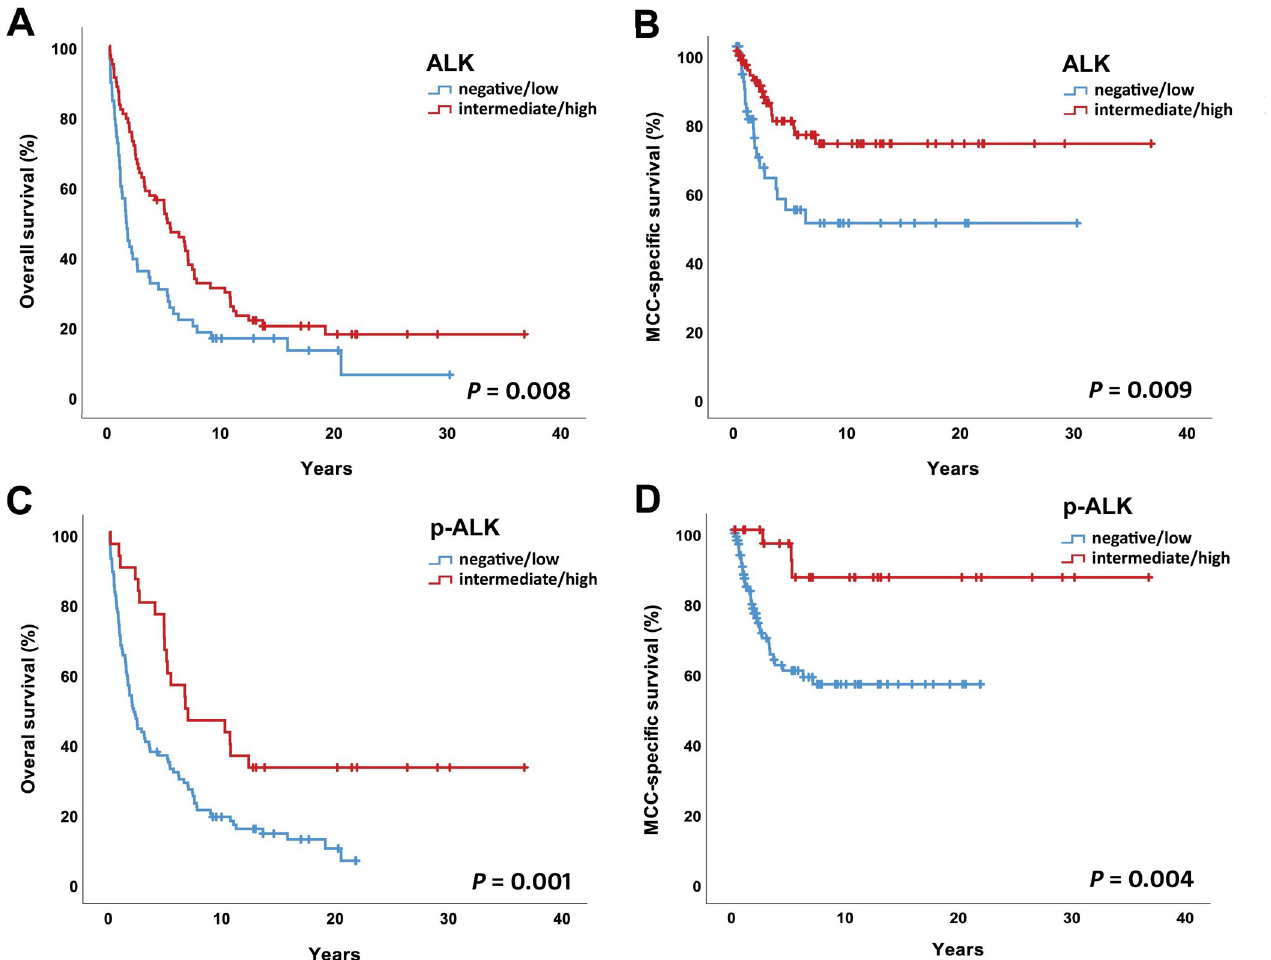
Fig 2. Overall and MCC-specific survival in relation to ALK and p-ALK status by